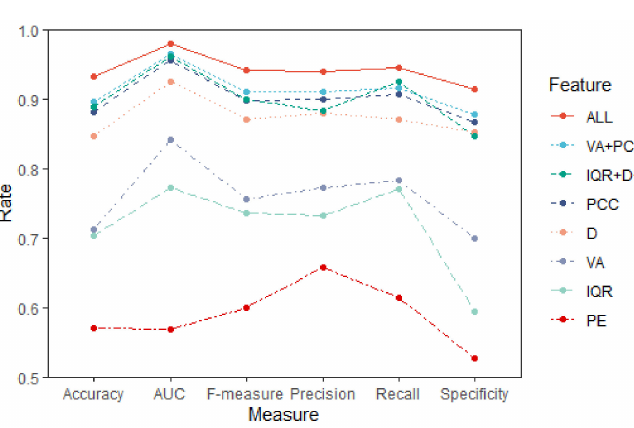
Figure 4. AD vs. NC discriminant results of the di ff erent features based on LDA (mean